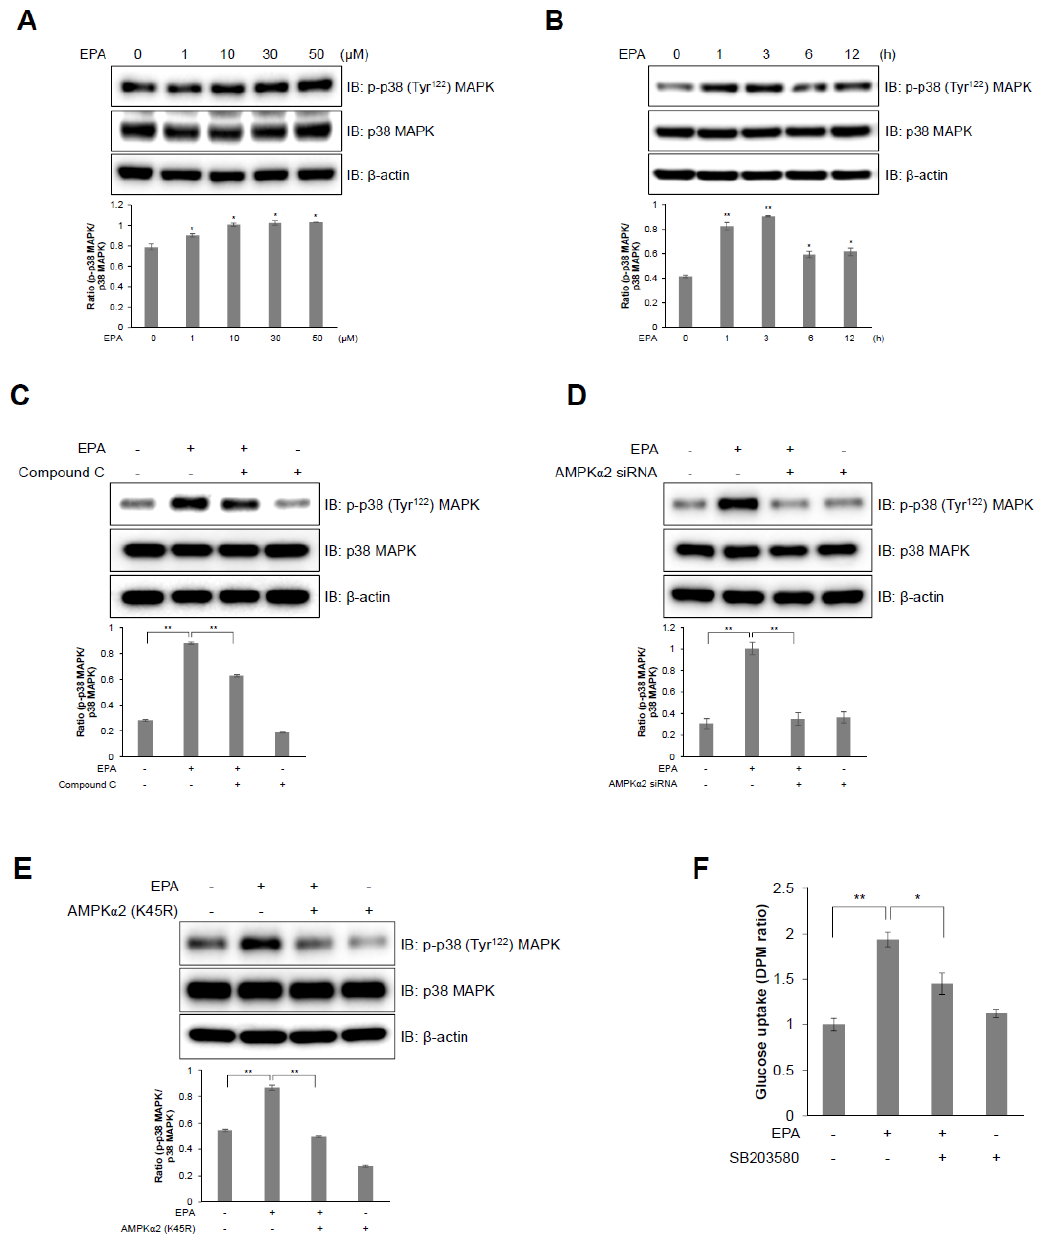
Figure 4. p38 MAPK plays as a downstream of AMPK in EPA-mediated glucose uptake in C2C12 myoblasts. ( A ) Western blot analysis of p38 MAPK phosphorylation in C2C12 cells treated with di ff erent concentrations of EPA for 3 h; or ( B ) 50 µ M EPA for the indicated times. ( C ) C2C12 myoblasts were treated with 50 µ M EPA for 3 h in the presence of 5 µ M compound C. The levels of total p38 MAPK and β -actin are presented as loading controls. ( D ) Western blot analysis of cells transfected with AMPK α 2 siRNA (100 nM) for 2 days, and then treated with EPA. ( E ) C2C12 cells were transfected with AMPK α 2 K45R plasmid (4 µ g) and then treated with EPA. Proteins were extracted from the transfected cells and protein levels were measured via western blot analysis. ( F ) Uptake of 2-DG in di ff erentiated L6 myotubes pre-treated with SB203580 (5 µ M) and incubated with EPA for 3 h. * p < 0.05, ** p < 0.01 compared to untreated cells. Results from three independently replicated experiments are